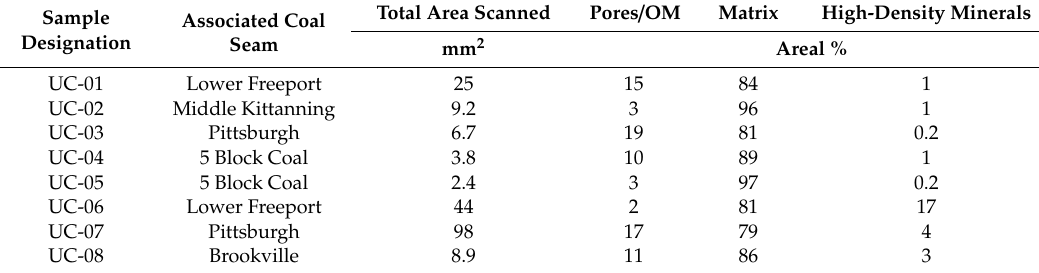
Table 5. Areal extents of phase classifications.